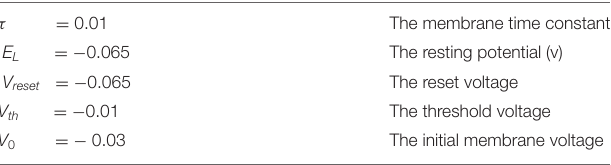
TABLE 1 | The parameters of the IF in the first, second, and third layers and in the output neuron.